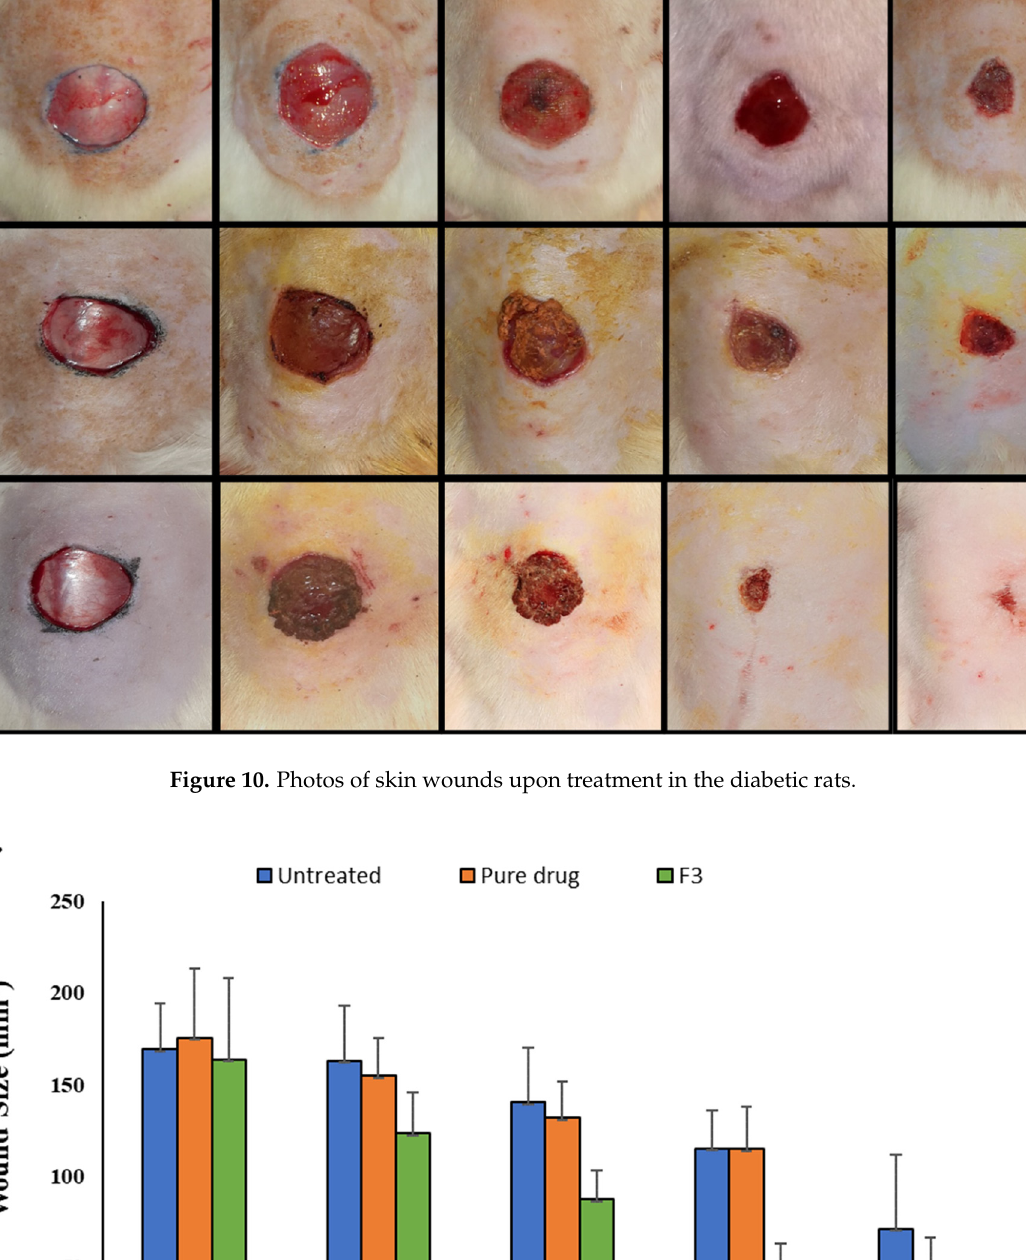
Figure 11. ( A ) Wound sizes (mm 2 ) and ( B ) percentage re-epithelialization in the diabetic rats upon treatment. The data suggested that curcumin’s therapeutic effects on wound healing and skin tissue regeneration were significantly improved while curcumin’s toxicity was minimized when the curcumin was formulated into the SEDDS. Using the free form of curcumin by adding it in DMSO and PBS 7.4 initiated precipitation and accumulation on the skin sur- face, which is not a favorable phenomenon in dermal delivery [64]. The in vivo results are well consistent with the in vitro cytotoxicity, cellular uptake, ROS inhibition, and cell migration data. Here, the SEDDS formulation increased the drug solubility, decreased the drug degradation, slowed down the drug release, and increased the drug uptake and efficacy at the wound site resulting in improved, persistent thera- peutic effects to accelerate the wound healing process in the diabetic rats [32,36]. Curcu- min promoted the migration of epithelial cells at the skin surface to the wound site in the proliferative stage, which was evident in the percentage re-epithelialization results